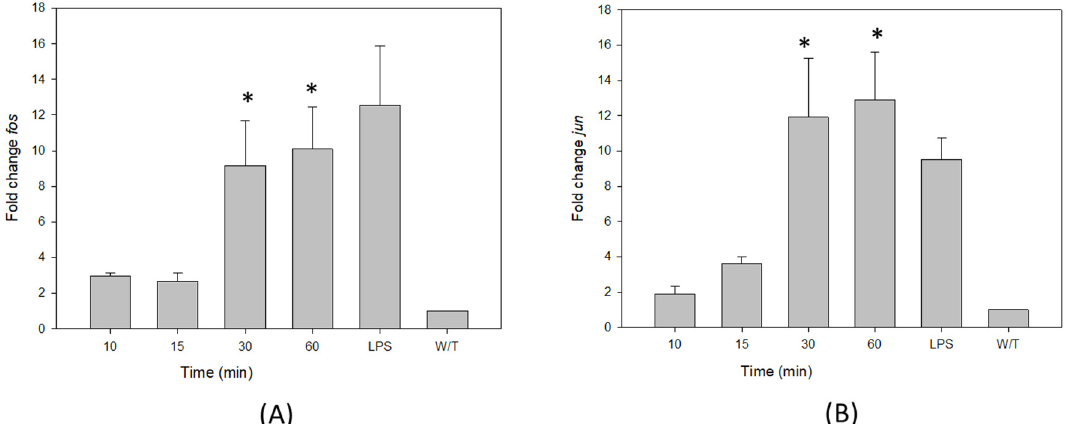
Figure 5. The VCC initiates messenger RNA expression of the transcription factor AP-1. Kinetics of transcriptional activation in THP-1 cells were performed by treatments with 40 pg/mL VCC during 10, 15, 30 and 60 min. LPS (1 µ g/mL) was the positive control. ( A ) Transcriptional activation of Fos. VCC starts the transcriptional regulation of the subunits of AP-1 Fos and Jun; then, its mRNA expression was studied by qp-PCR. ( B ) Transcriptional activation of Jun. VCC starts the transcriptional regulation of subunits of Jun, and its mRNA expression was evaluated using qp-PCR. Changes in transcriptional expression were established in comparison with the untreated control and then normalized with the housekeeping gene NAPDH. The graphic includes results from three performed experiments. W/T, without treatment. Mean ± SD. * p < 0.001, significantly different from the group without treatment (ANOVA plus the Student–Newman–Keuls method).